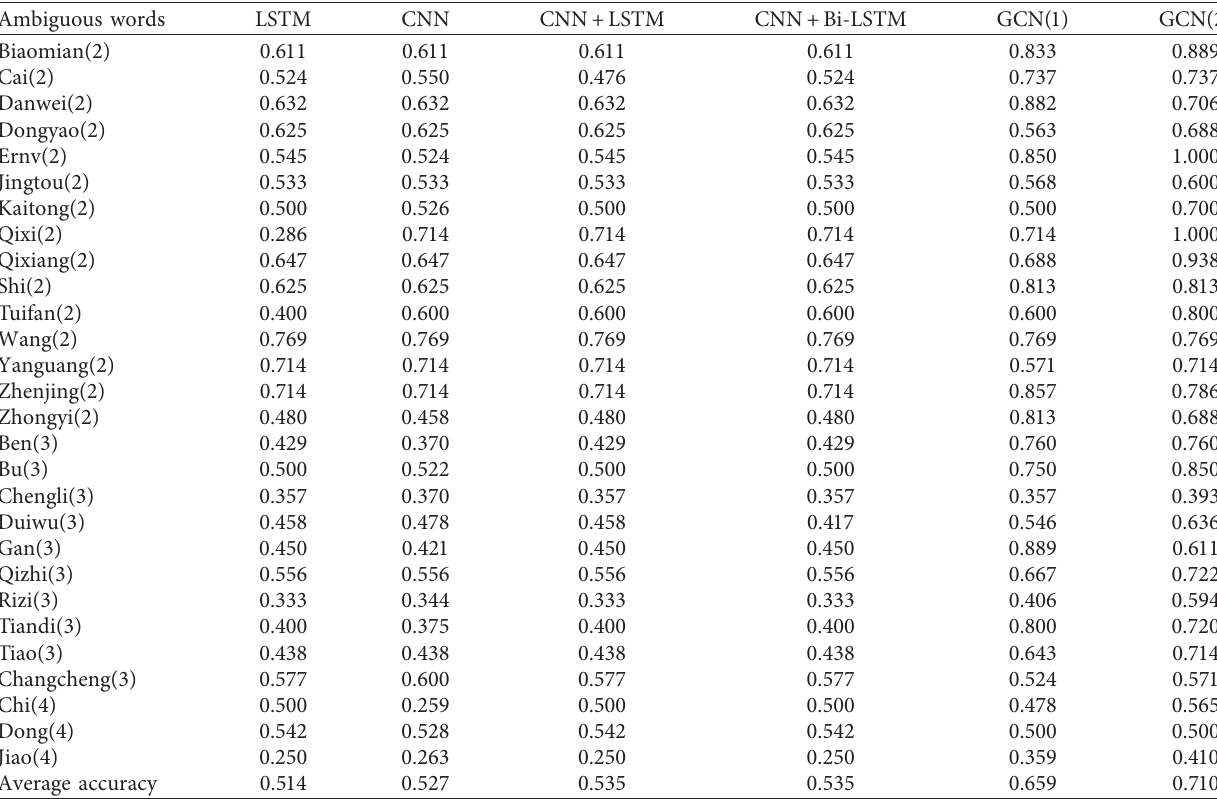
Table 1: Disambiguation accuracies in the first group of